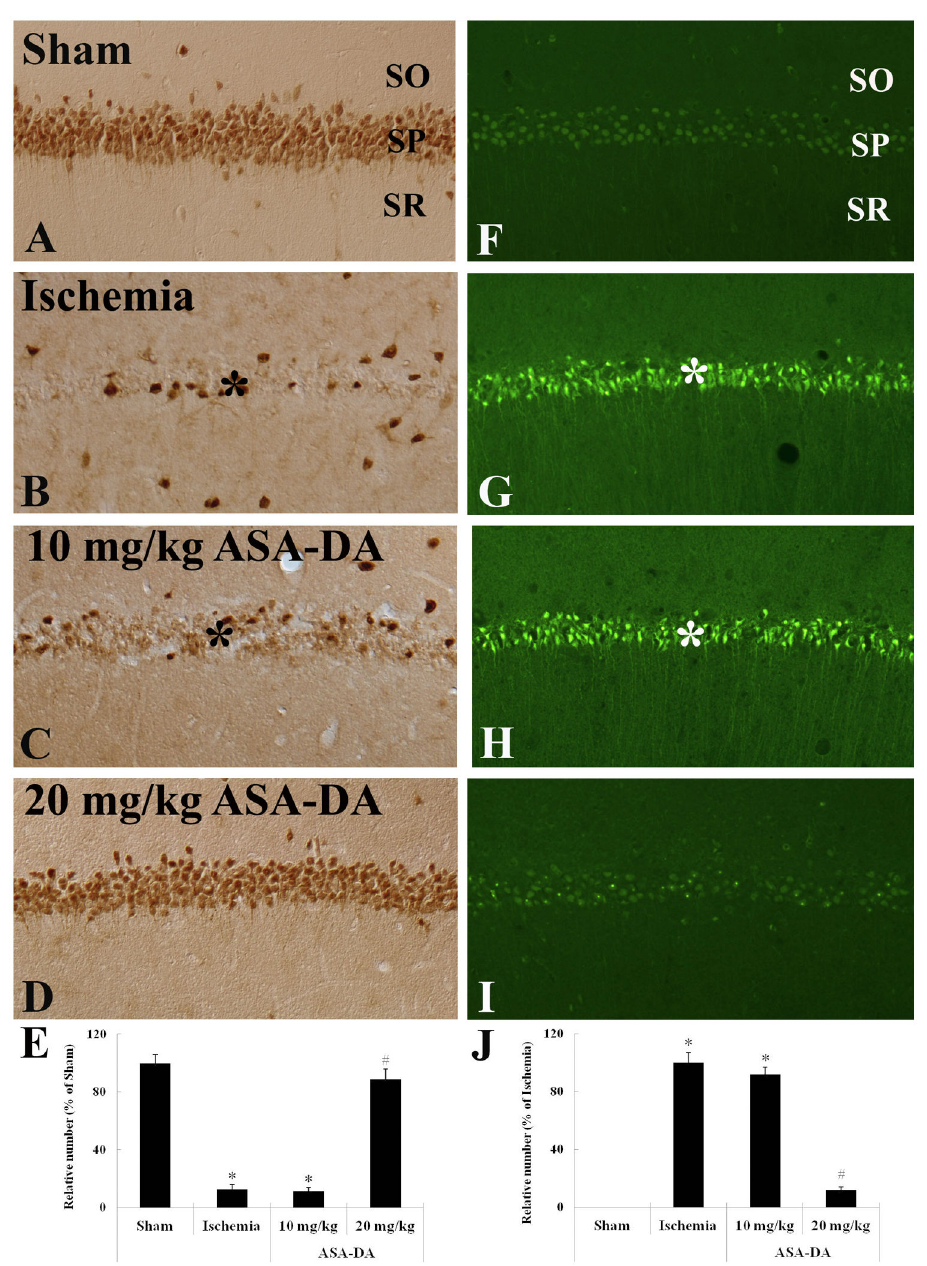
Figure 5. NeuN immunohistochemistry and F-J B histofluorescence. NeuN immunohistochemistry (A-E) and F-J B histofluorescence (F-J) in the CA1 region of the vehicle-sham-, vehicle-ischemia-, 10 and 20 mg/kg ASA-DA-pre-ischemia-groups at 5 days after ischemia-reperfusion. NeuN immunoreactivity is easily detected in the stratum pyramidale (SP) of the CA1 region of the vehicle-sham- and 20 mg/kg ASA-DA-pre-ischemia-groups. In the vehicle-ischemia- and 10 mg/kg ASA-DA-pre-ischemia-groups, many F-J B+ cells are detected in the SP (asterisks). Relative analysis (E and J) as percent in the mean number of NeuN+ and F-J B+ cells in the CA1 region (n = 7 per group; *P < 0.05, significantly different from the vehicle- sham-group, #P < 0.05, significantly different from the vehicle-ischemia-group). The bars indicate the means ± SD.